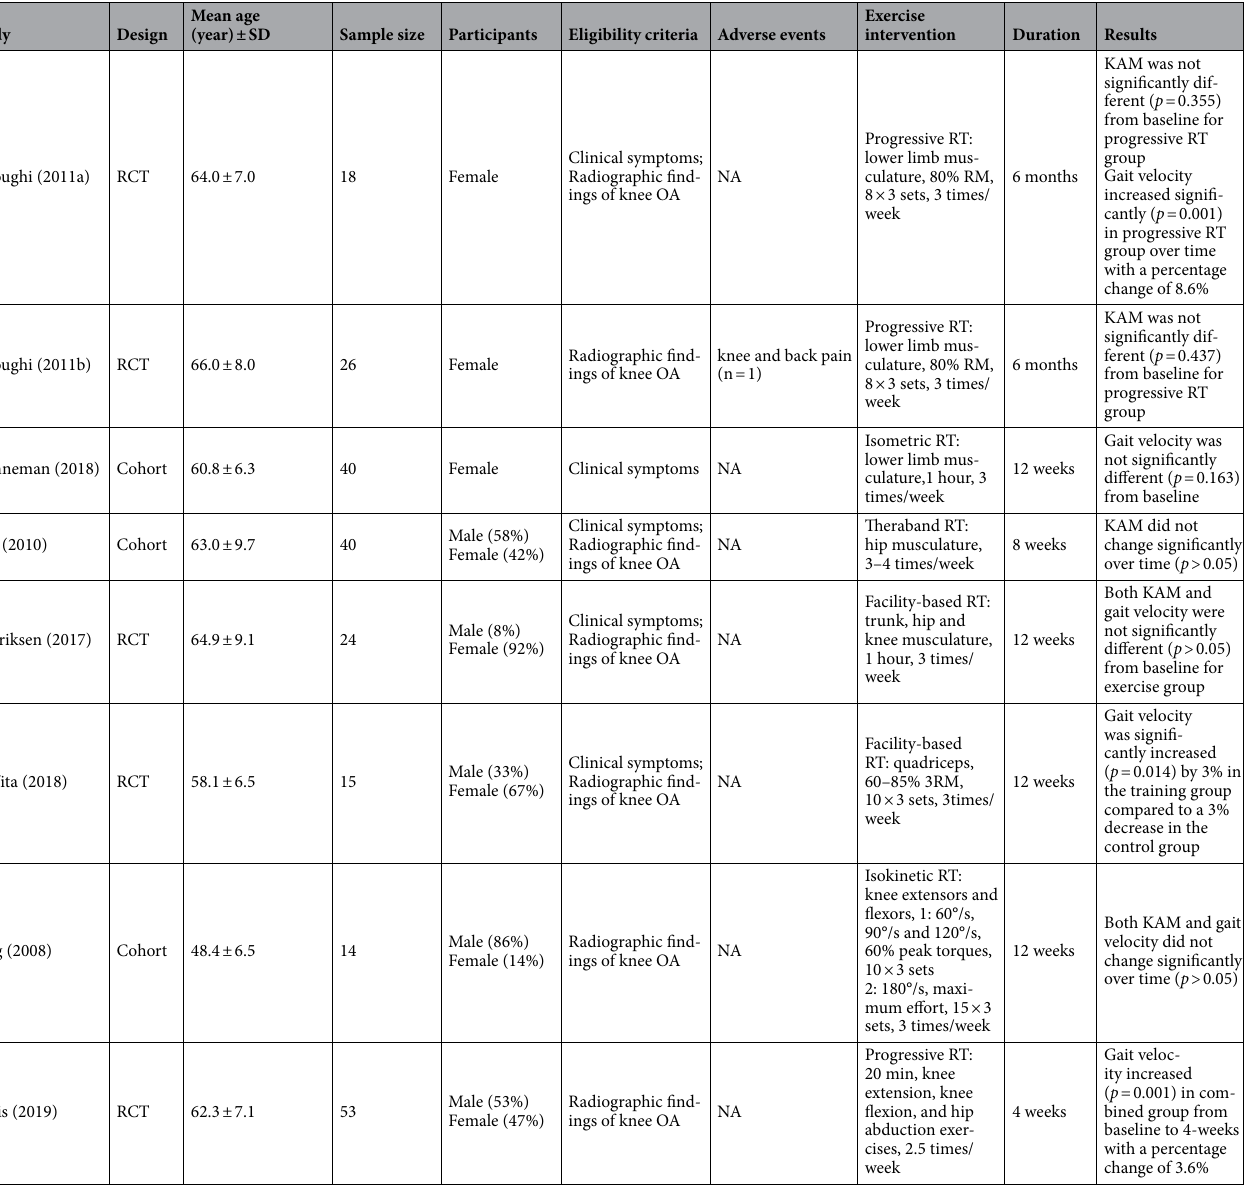
Table 1. Characteristics of included studies. RT resistance training; KAM knee adduction moment; OA Osteoarthritis; RCT randomized controlled trials; NA not available; RM repetition